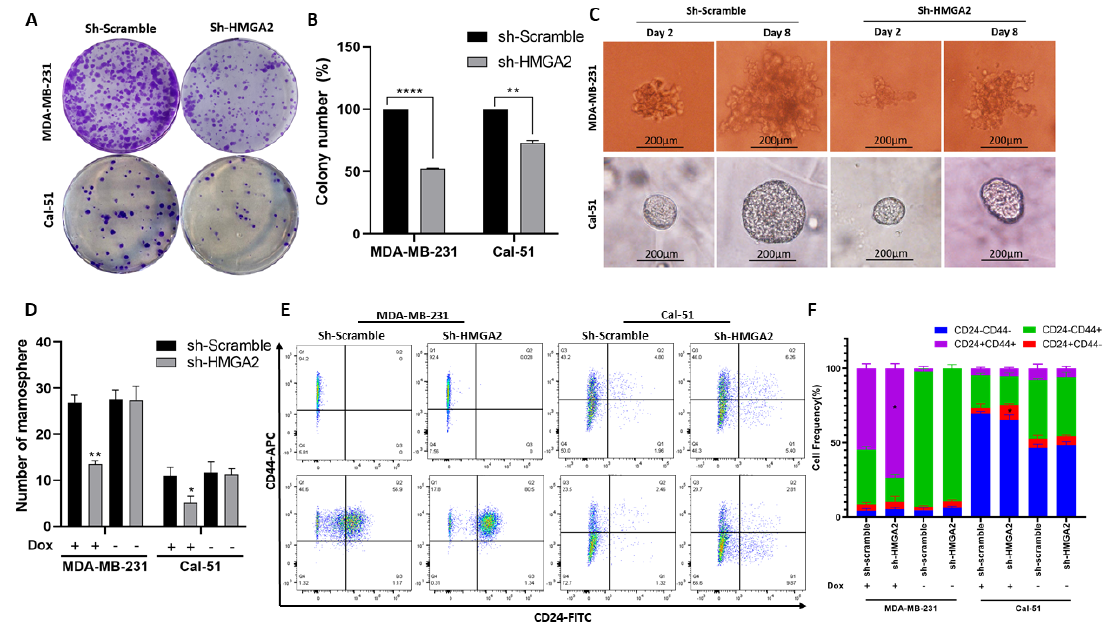
Figure 5. HMGA2 silencing decreases stemness of TNBC cells. A colony formation assay showed a significant decrease in colony numbers in cells with doxycycline (DOX)-induced HMGA2 knockdown (shHMGA2) ( A ). Colony numbers quantified and compared to shScramble group in both TNBC cell lines ( n = 3) ( B ). Micrograph showing the size of mammospheres ( C ) and bar graph showing the number of mammospheres ( D ), which were reduced upon HMGA2 knockdown in both TNBC cell lines. The fraction of CD44+CD24+ in MDA-MB-231 and the population of CD44-CD24+ in Cal-51 increased after HMGA2 silencing compared to shScramble cells ( E , F ). The results are shown as mean ± SD ( n = 3) versus the shScramble group, * p < 0.05, ** p < 0.01, **** p < 0.0001 by t -test.